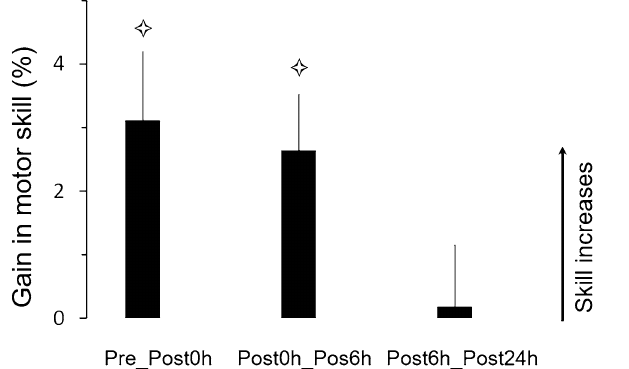
Figure 5. Control Experiment 2. Average values (+ SE) of gains (%) in motor skill between sessions. Stars indicate significant differences from the value zero